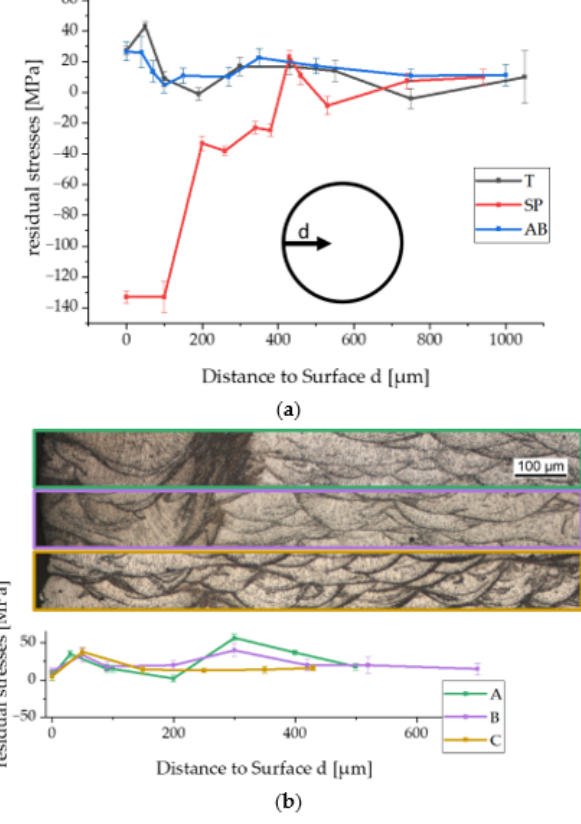
Figure 7. ( a ) Residual stress–depth profiles of as-built (AB), shot peened (SP) and turned (T) spec- imens. ( b ) Residual stress–depth profile of contour parameters A, B and C. The curves call the